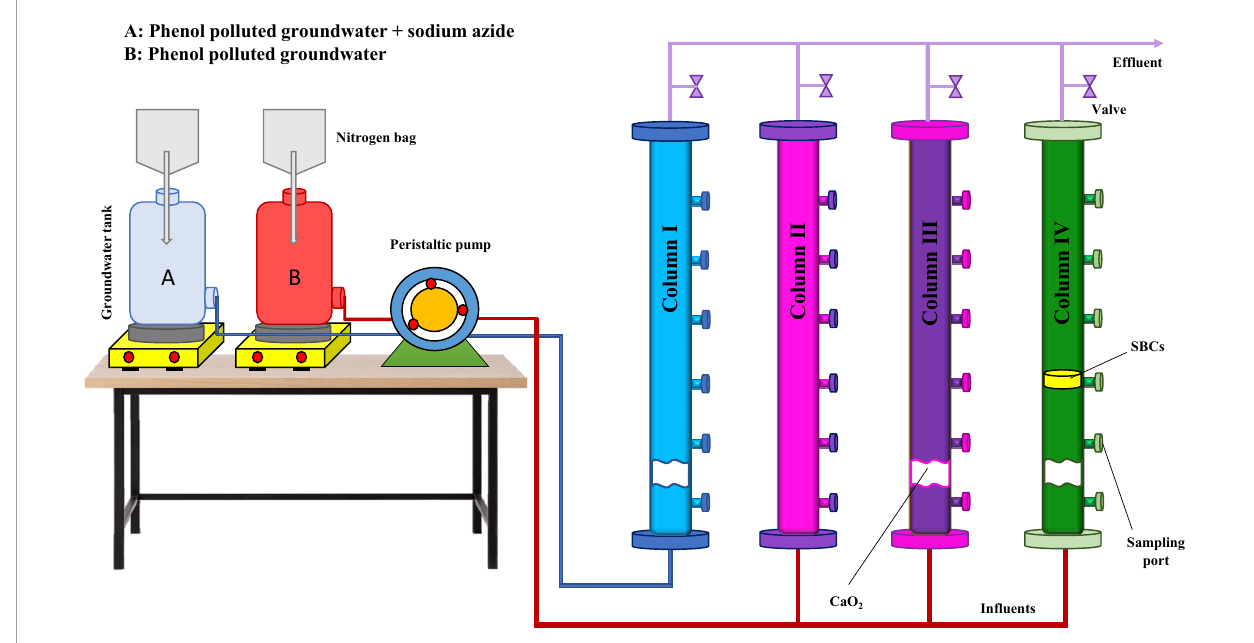
FIGURE1 Schematic representation of column experiments. Column I: phenol removal in the abiotic condition by CaO 2 nanoparticles (chemical), column II: natural bioremediation of phenol (blank), column III: phenol remediation by CaO 2 nanoparticles and native groundwater microbial population (biostimulation), and column IV: phenol remediation by CaO 2 nanoparticles and SBCs (biostimulation and bioaugmentation).